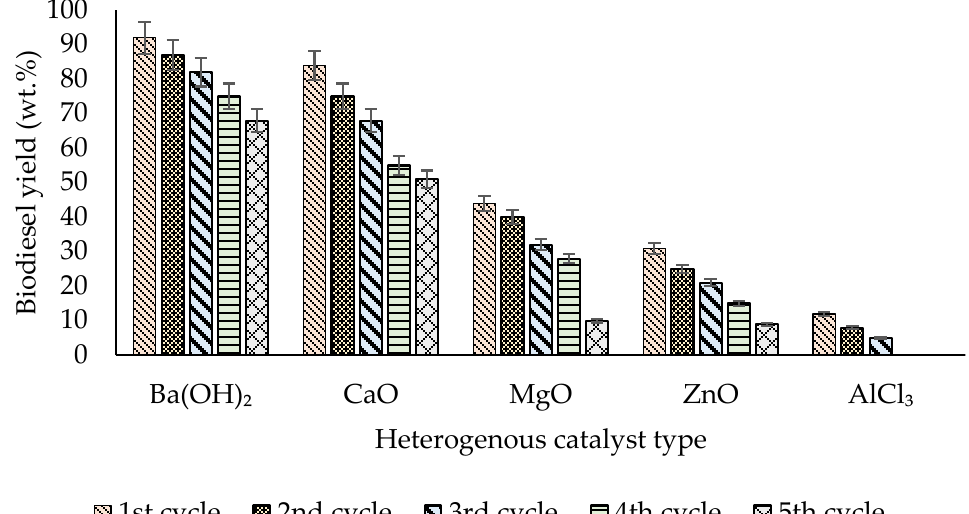
Figure 9. Effect of reuse of heterogeneous catalyst on biodiesel yield. (Catalyst loading 5 wt%; methanol-to-oil molar ratio of 12:1, time 120 min temperature 60 °C; reaction speed 600 rpm.)